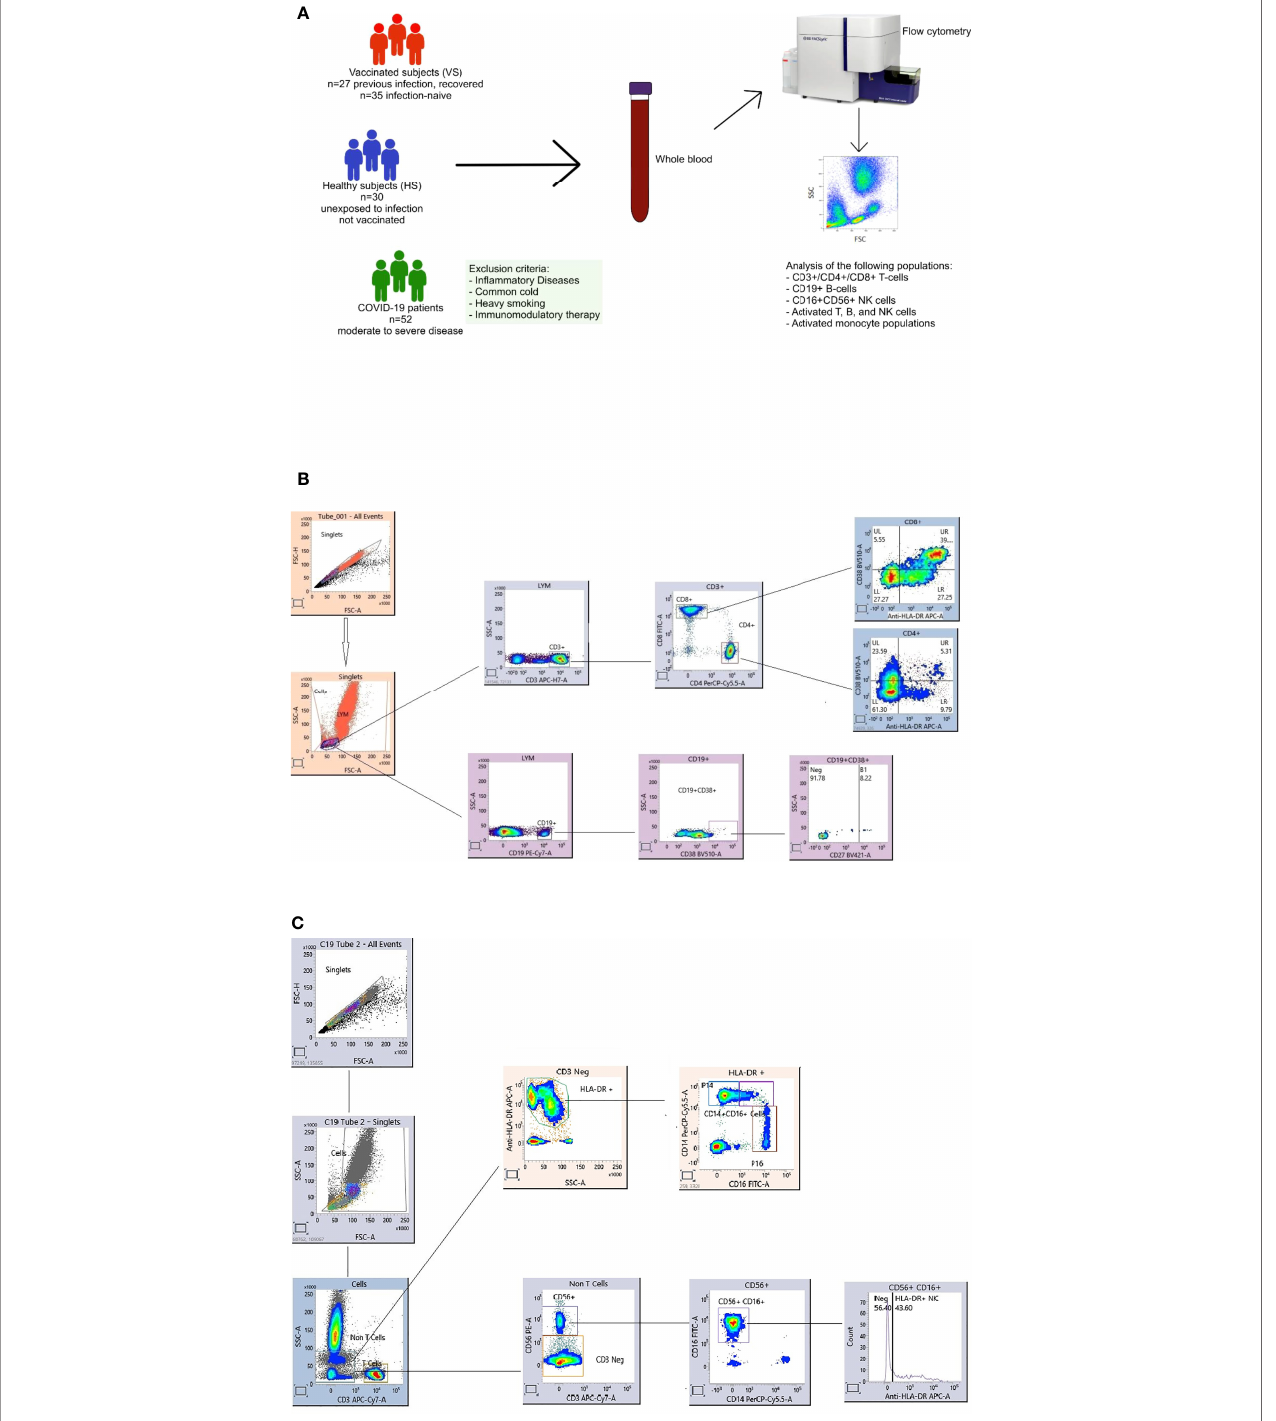
FIGURE 1 | Overview of the study including healthy subjects (HS), COVID-19 patients and vaccinated subjects (VS) (A) . Flow cytometry gating strategy for immune cell subsets. Gating panels are shown for (B) CD27+CD38+CD19+ antibody-secreting B cell (ASCs, plasmablasts) and activated CD38+HLA-DR+CD4+ and CD38 +HLA-DR+CD8+ T cells and (C) activated HLA-DR+NK cells and monocyte subpopulations. Fresh whole blood (100 microlitre per stain) was used to measure the percentage of CD3-CD19+CD27+CD38+ ASC populations, in addition to activated HLA-DR+CD38+CD8+ and HLA-DR+CD38+CD4+ T cells. Another tube of blood was stained for the percentage of in fl ammatory CD14+CD16+, CD16+ and conventional CD14+ monocytes and, activated HLA-DR+CD3-CD16+CD56+ NK cells. After staining the whole blood was for 20 mins at room temperature (RT) in the dark, samples were lysed with BD FACS Lysing solution, washed and fi xed with 1% paraformaldehyde. All the stained blood samples were acquired on a FACS Lyric fl ow cytometer (BD). Flow cytometry data were analyzed using FACS Suite Research